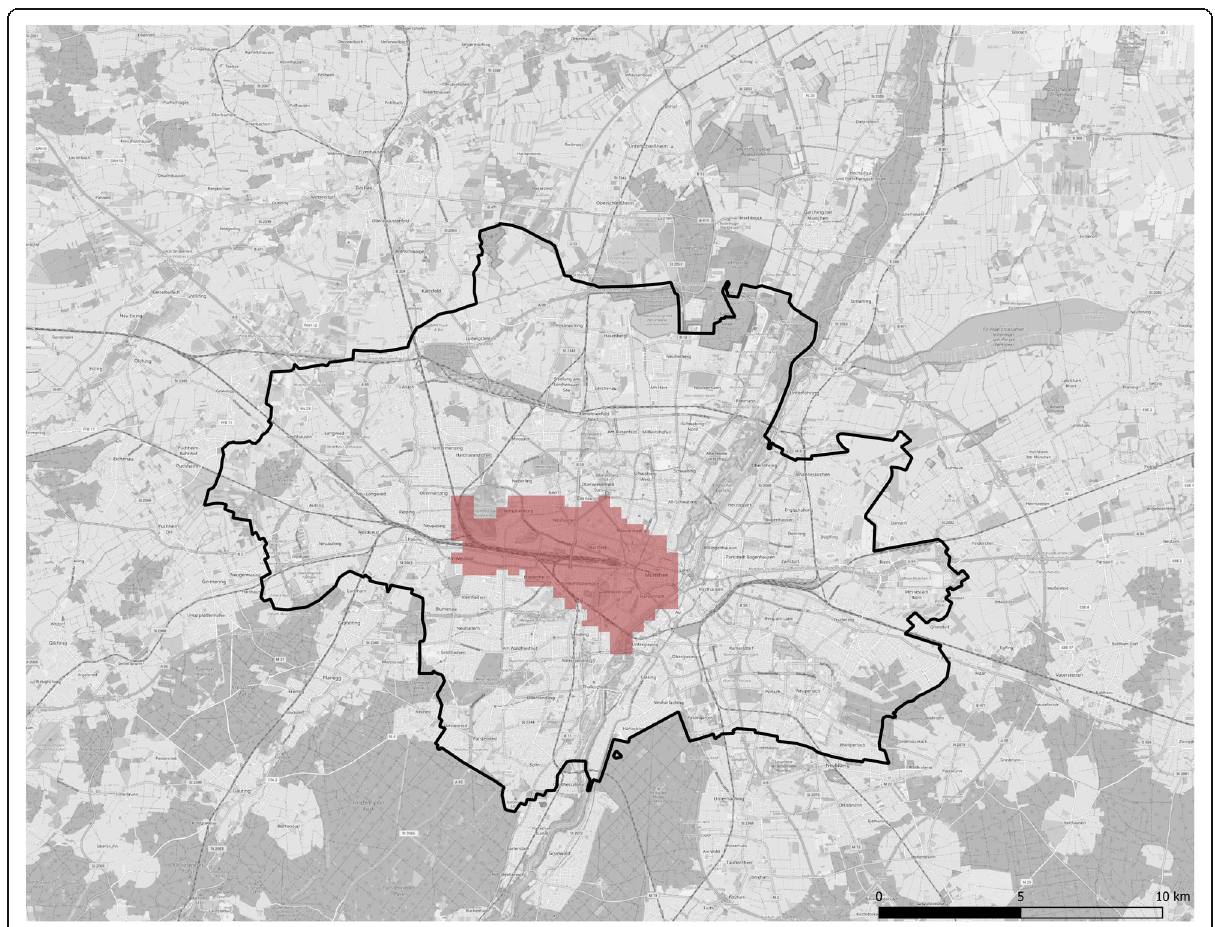
Fig. 3 Boundaries of the city of Munich (Germany). The catchment area of the distribution center is marked in red (background map: